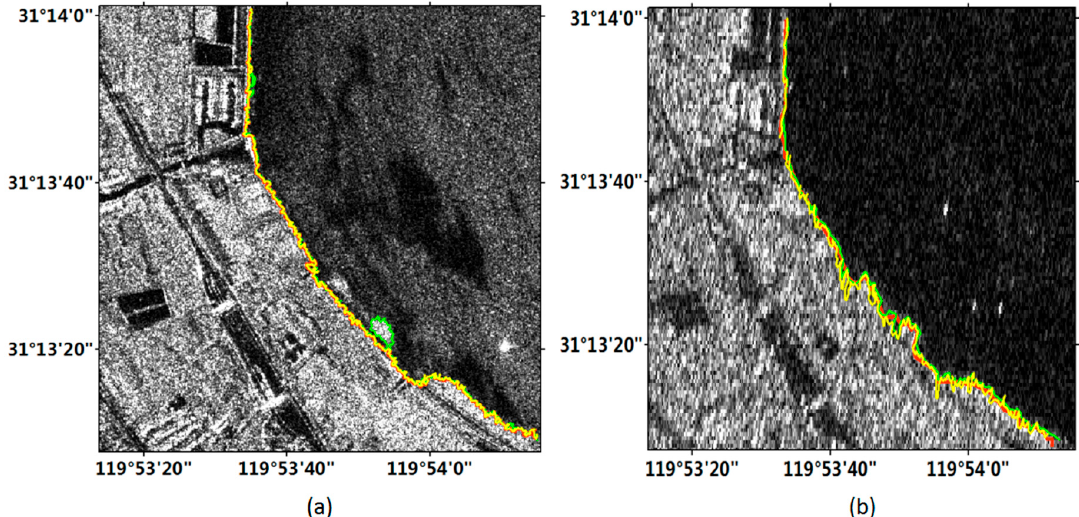
Figure 9. Experimental results of sub-region in Figure 8. Red line represents the manually delineated coastline. Yellow and green lines represent the coastline detection results from the improved and original FCM methods, respectively. ( a ) Gaofen-3 image; ( b ) Sentinel-1 image.